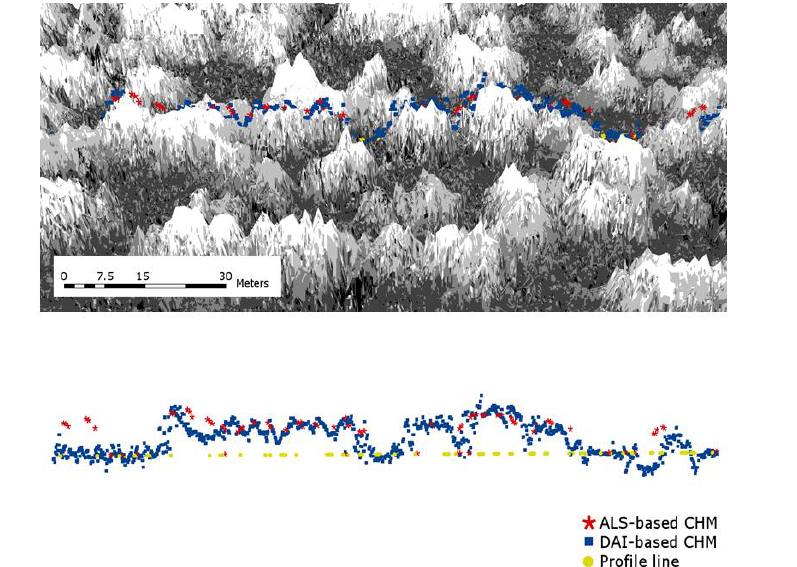
Figure 3. Example of a side view of a profile of an ALS-based and a DAI-based canopy height model overlaid with a 3D photogrammetric digital surface model reconstruction. Profile width = 1 m, length = 105 m.